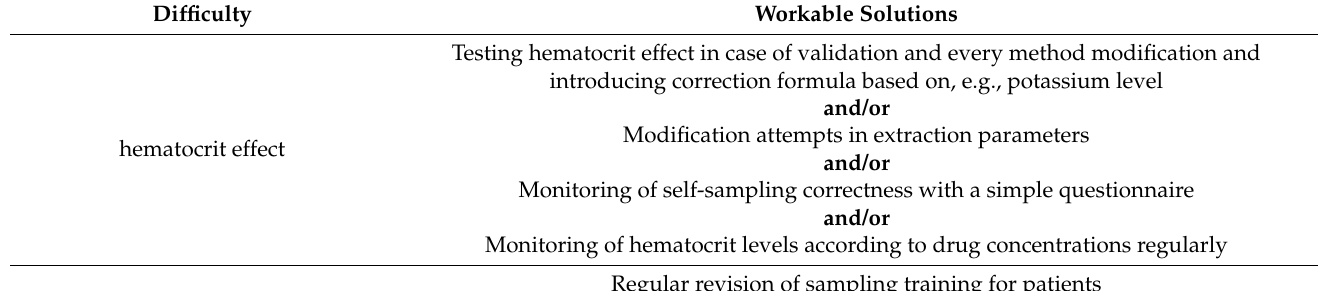
Table 4. Potential solutions for selected analytical and preanalytical aspects of